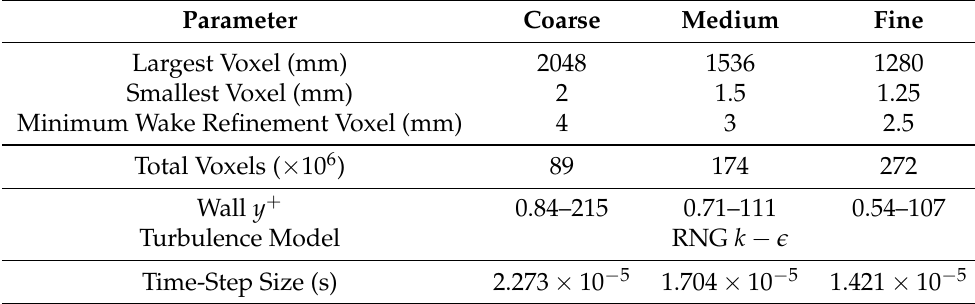
Table 1. Key mesh parameters in the mesh generation of the